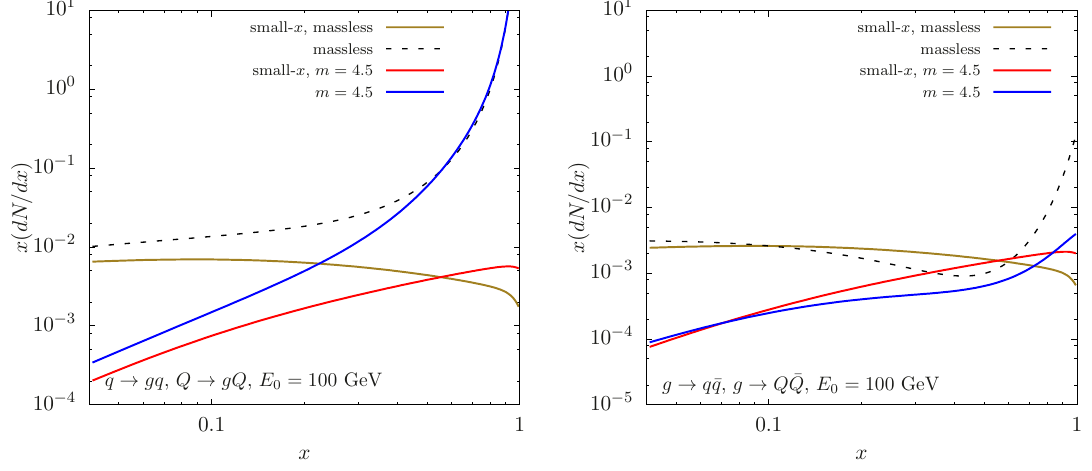
and (cid:1) z integrals are evaluated ? = 2 = 20 GeV (left) and 0